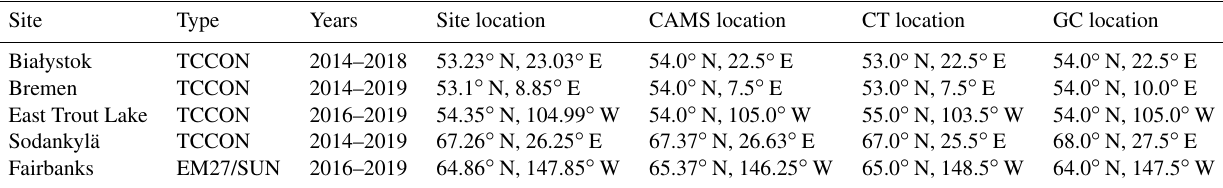
Table 1. Summary of instrument type, years of observations, geographic coordinates, and corresponding coordinates of the nearest model grid point in CAMS, CT2019B (CT), and GC-CT2019 (GC) for each ground